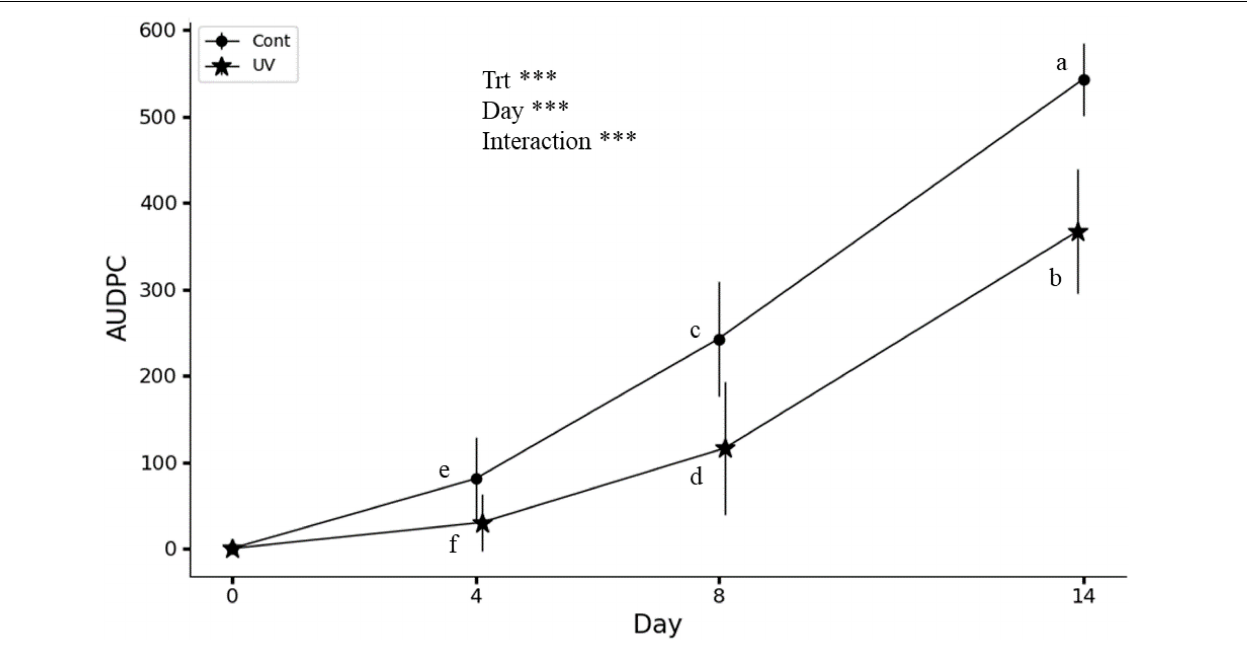
FIGURE 1 | Effect of UV-C treatments on AUDPC (area under the disease progress curve). Treatments (Trt): Cont (control), UV (1.6 kJ/m 2 ). Two-way ANOVA indicates a significant effect of treatments, assessment days (0, 4, 8, and 14) for BLS (bacterial leaf spot) and their interaction. AUDPC means are statistically different at P < 0.05 according to the Duncan’s multiple range test, n = 9, ∗∗∗ P < 0.001. Different letters indicate a significant difference between treatments at the same day or on different days (4, 8, and 14). The vertical bars show the standard deviation.